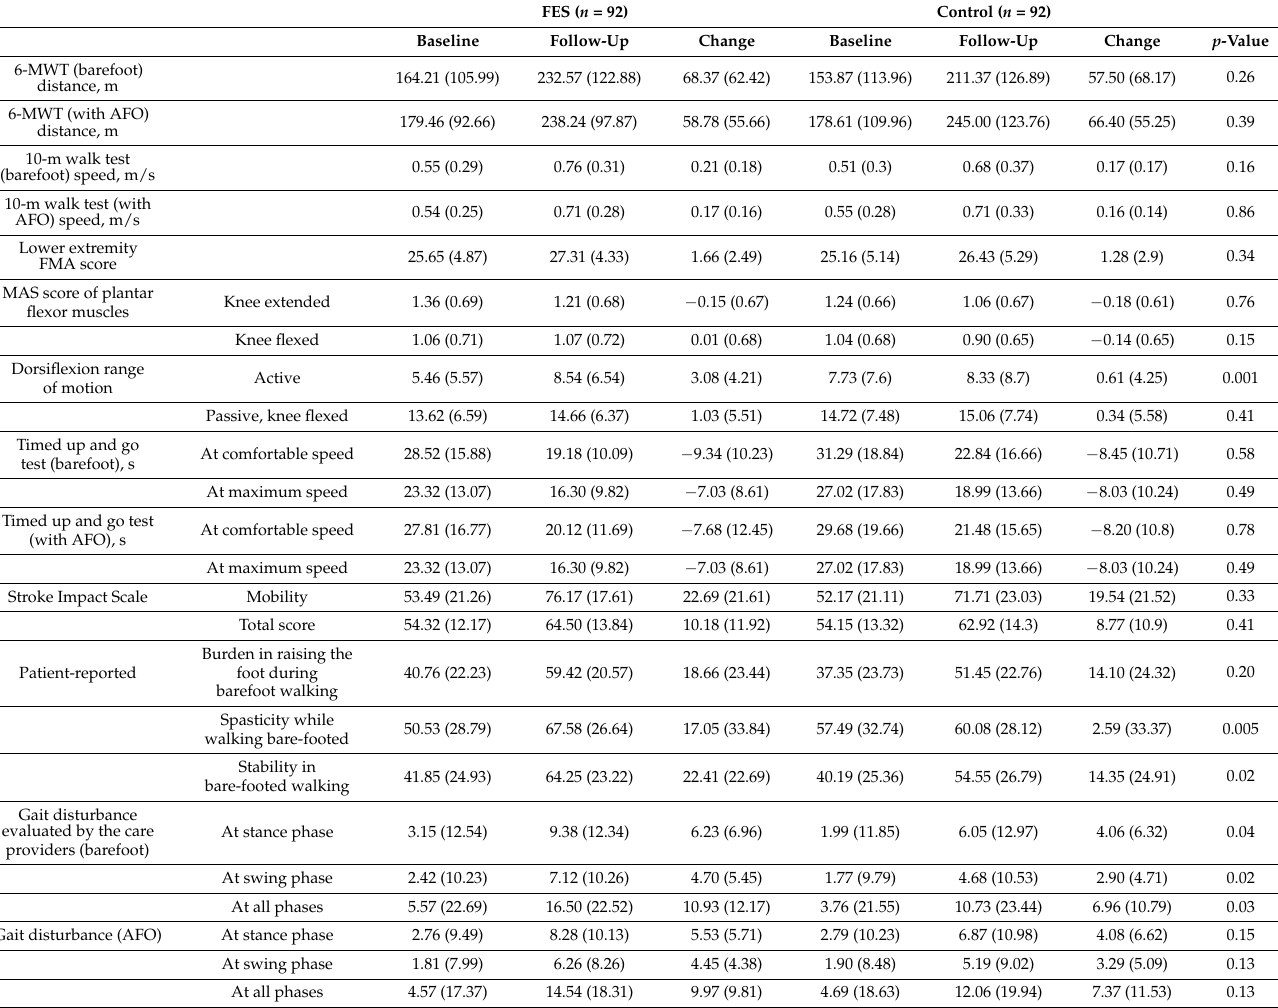
Table 2. Primary and secondary outcomes. Data are presented as means (SDs). No conclusions can be made regarding differences in secondary outcomes because of the lack of planned adjustment for multiple comparisons. Abbreviations: 6-MWT, 6 min walk test; AFO, ankle-foot orthosis; FMA, Fugl–Meyer Assessment.